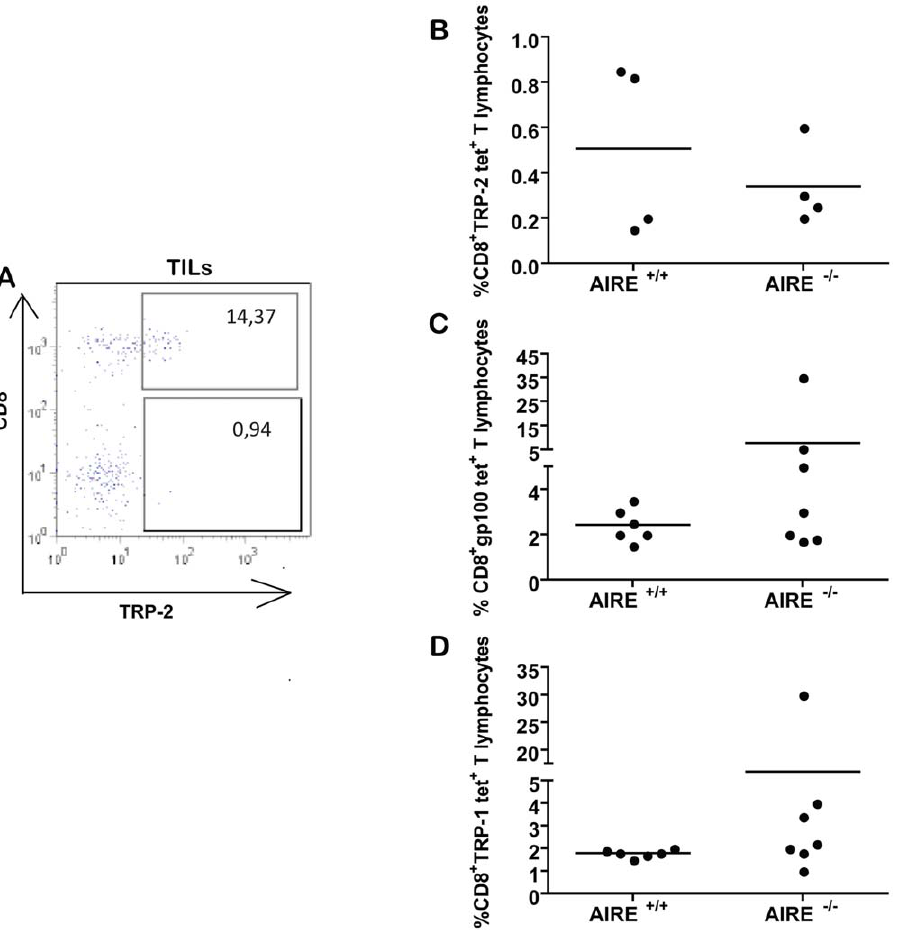
Figure 6. MAA-specific CD8 + T cells present in TILs and draining LNs. A Wildtype mice were injected with 10 6 live B16F10 and 10 days later, TILs were isolated and stained for CD8 and TRP-2-specific TCR using tetramers. B and C Mice of indicated genotypes were primed and challenged with B16F10 cells, then frequencies of gp100, TRP-1 or TRP-2 tetramer positive cells in the CD8 + T cell population were plotted. Representative of two similarly conducted experiments.